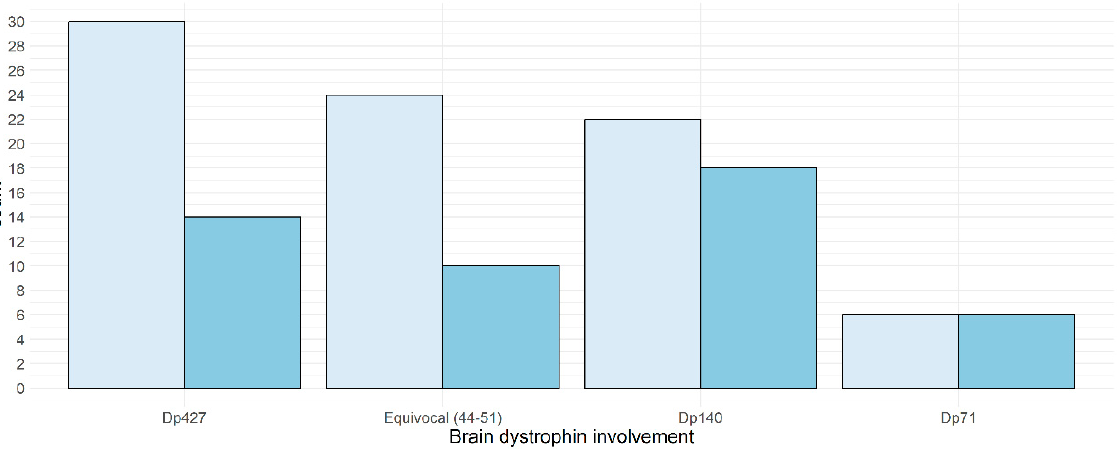
Figure 6. IQ changes (more or less 11 points) in patients subdivided according brain dystrophin involvement. Key to figures: light blue < 11 points, blue ≥ 11 points.